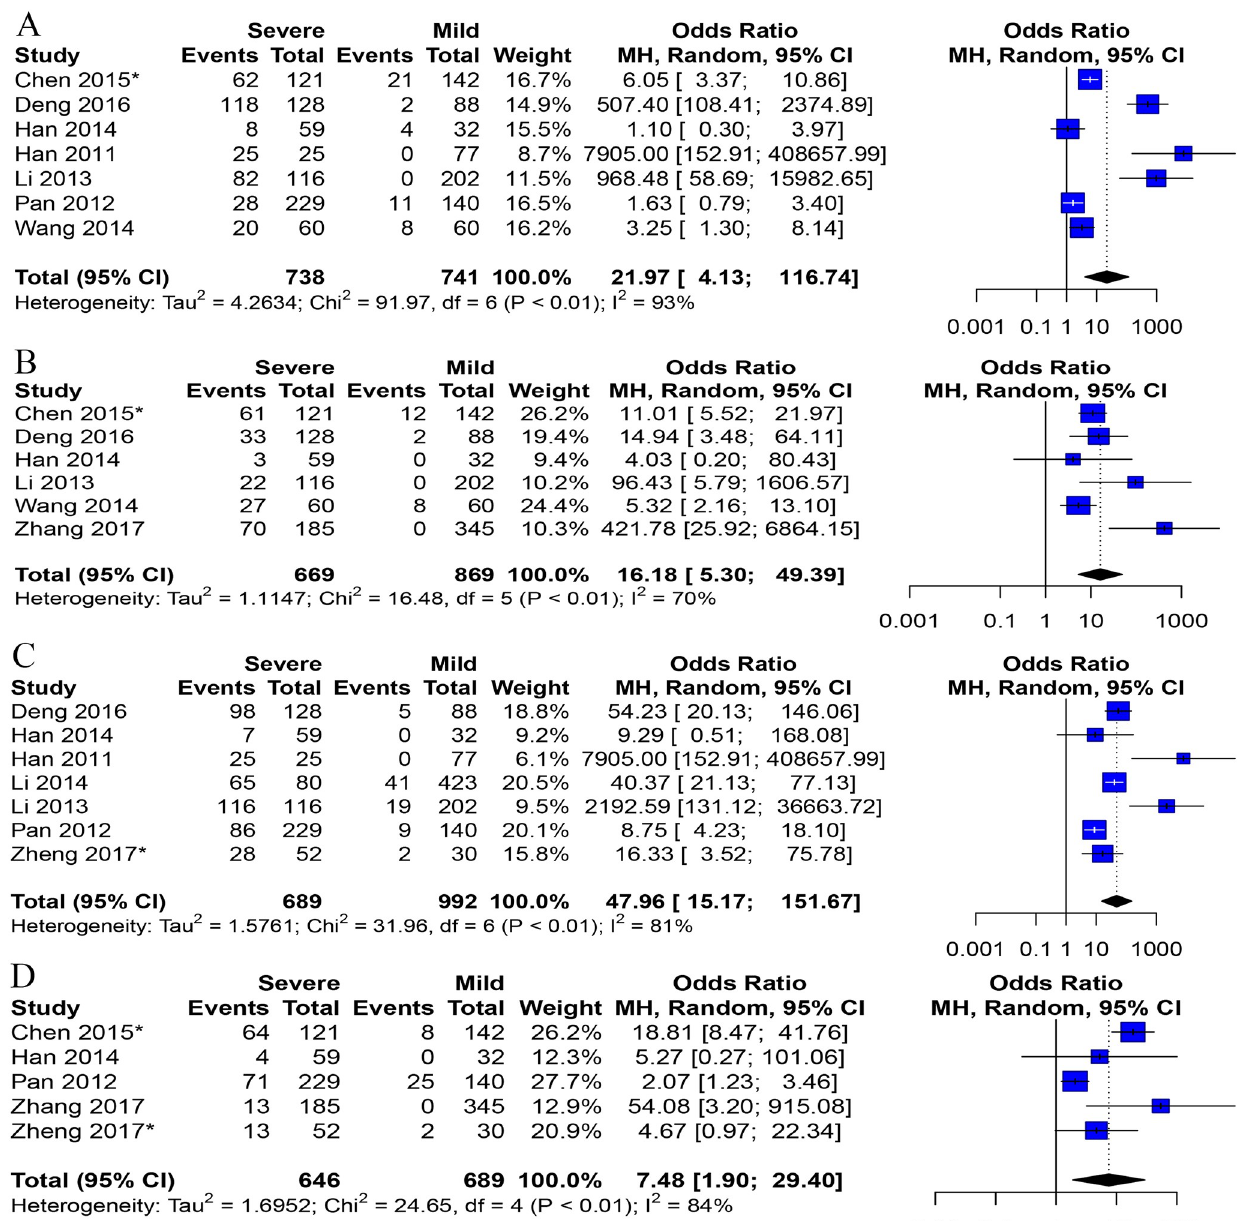
Fig 2. Forest plots of meta-analysis on a panel of clinical signs. A Hypersomnia, B convulsion, C Limb shaking, D Breathlessness. � Data is converted from the original data.